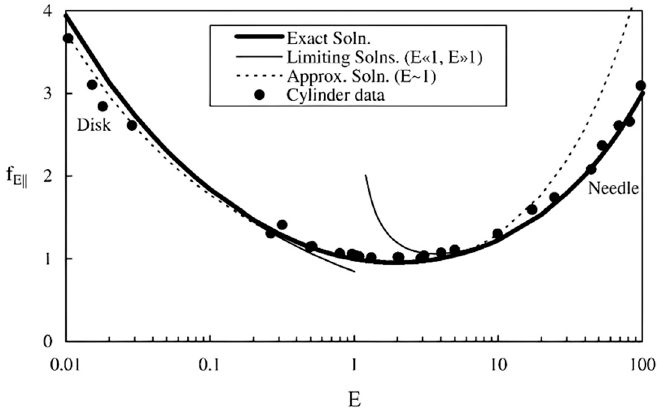
Figure 1. Effect of eccentricity on sphere trajectory correction [28].